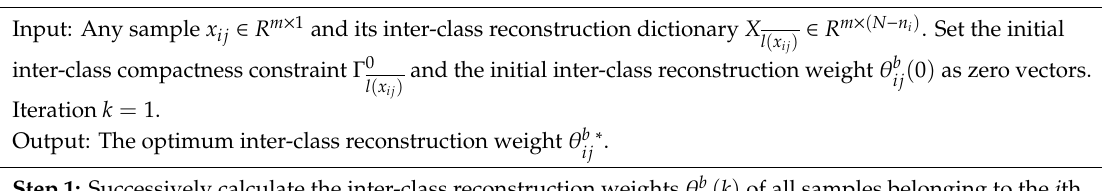
Algorithm 2 The inter-class reconstruction weight optimization algorithm (Solving Equation